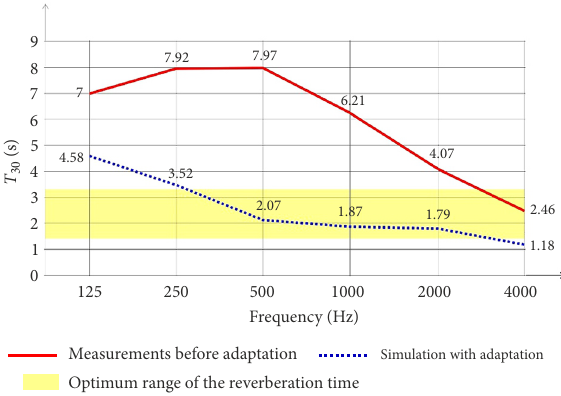
Figure 11. Comparison of reverberation time T 30 in the fre- quency function for in situ measurements and simulation